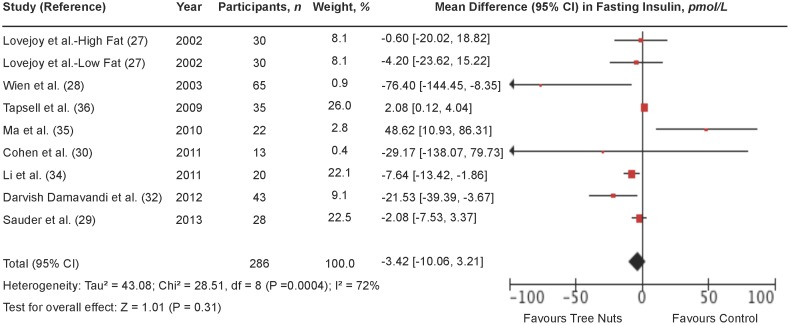
Forest plot of randomized controlled trials investigating the effect of diets supplemented with tree nuts on fasting insulin in individuals with type 2 diabetes.Pooled effect estimate (diamond) for fasting insulin (pmol/L). Data are expressed as weighted mean differences (MD) with 95% CIs, using the generic inverse-variance random-effects model. Paired analyses were applied to all crossover trials. Inter-study heterogeneity was tested by the Cochran Q-statistic and quantified by I2 at a significance level of P<0.10. n = number of participants in each treatment group.